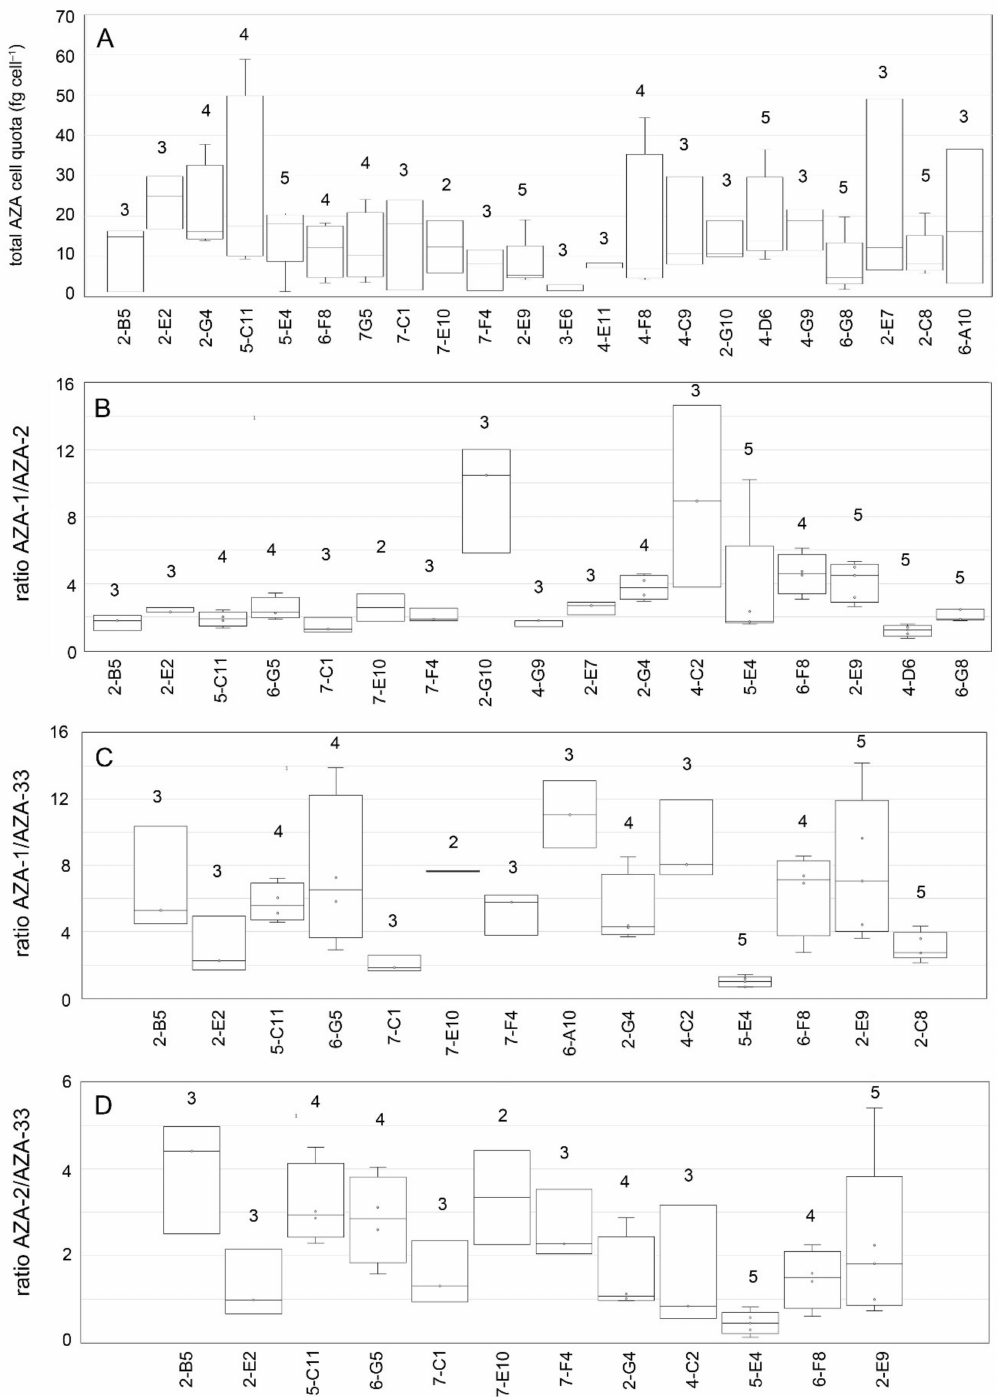
Figure 10. Azadinium spinosum ribotype A strains. Variability in total AZA cell quota ( A ) and AZA ratios ( B – D ) based on multiple analysis of single strains. Number above bars indicate the number of analyses ( n